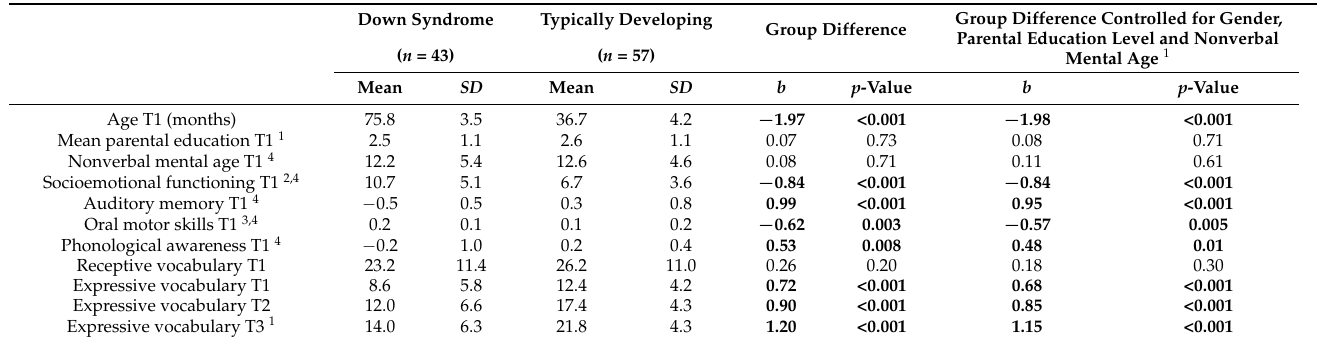
Table 2. Descriptive information of the